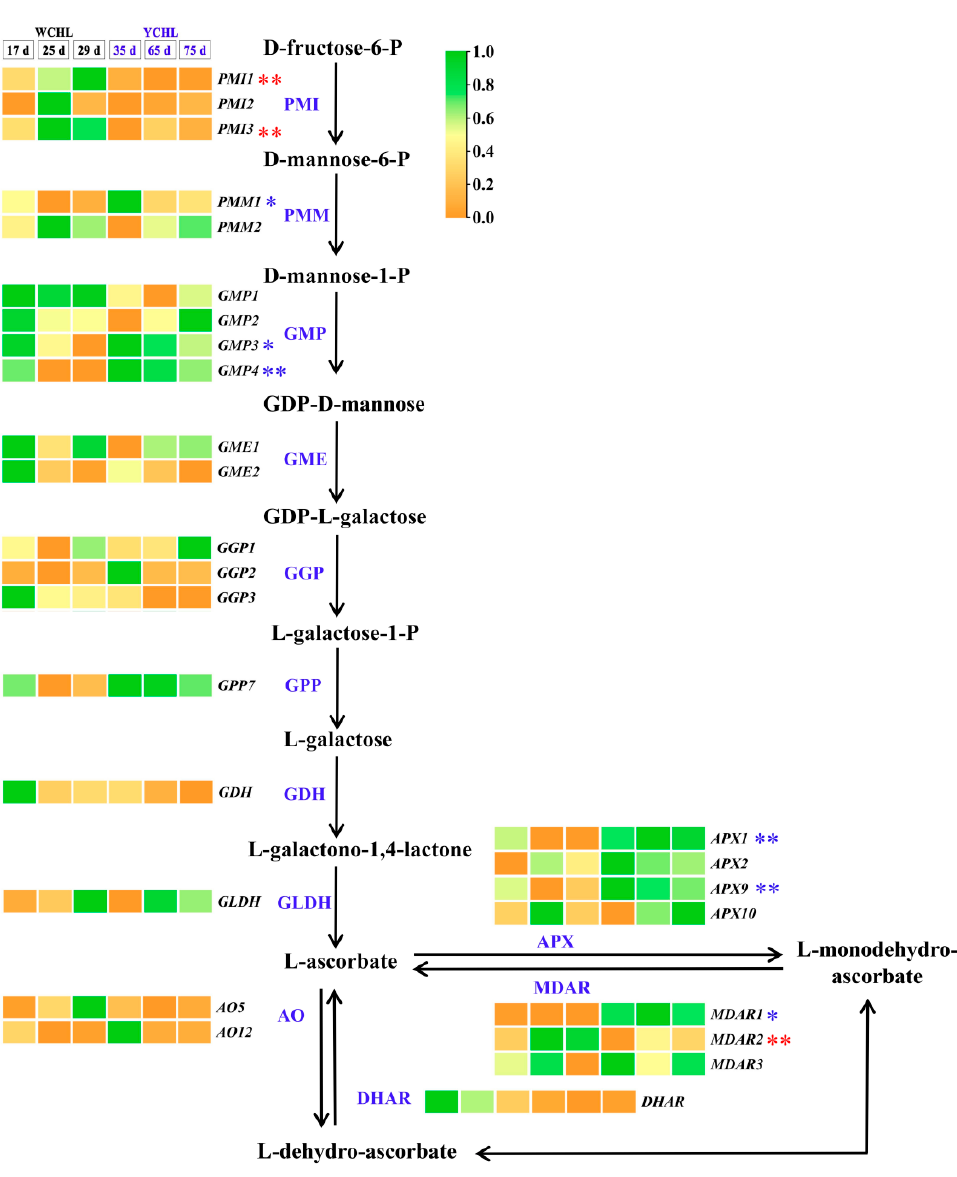
Figure 6. The transcript abundance of candidate genes involved in the proposed L-galactose pathway of ascorbate biosynthesis and regeneration during fruit maturation of ‘WCHL’ and ‘YCHL’ pitayas. Gene abbreviations are shown in Table S3. The correlation analyses of ascorbic acid contents and gene expressions are labeled as * ( p < 0.05, two-tailed) or ** ( p < 0.01, two-tailed), red indicates positive relationship while blue is negative.